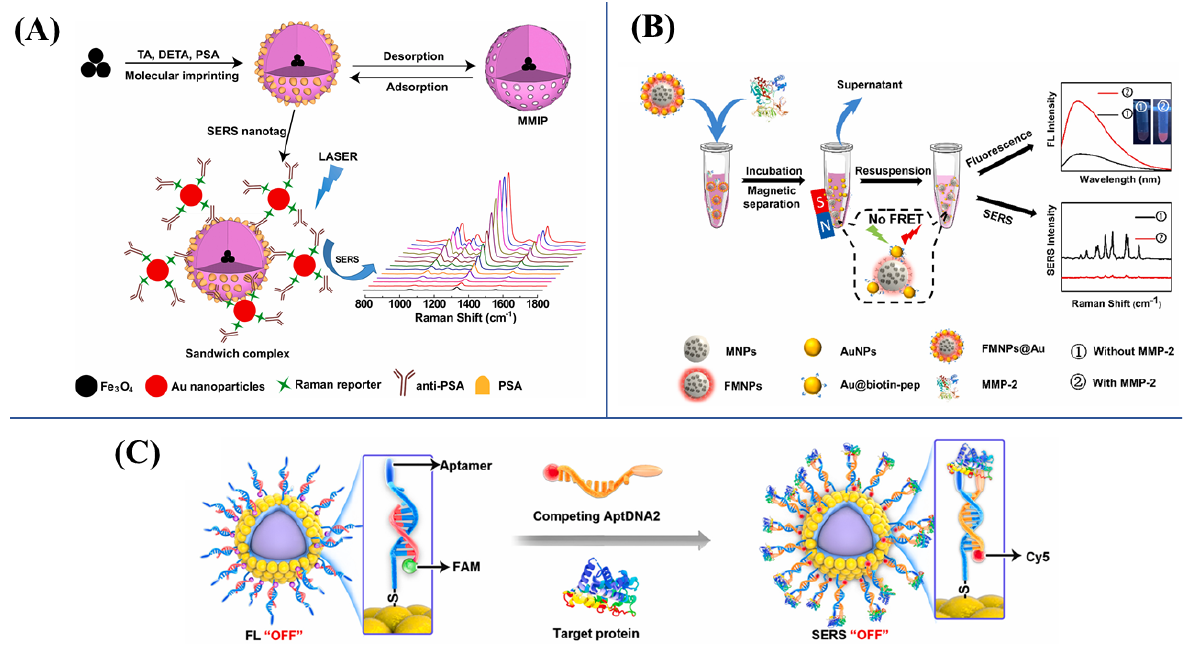
Figure 6. ( A ) Construction of SERS-based platform for PSA detection using MMIPs. Reproduced with permission from Ref. [131]. Copyright 2021, Elsevier. ( B ) Sensing principle of the FMNS@Au dual-mode nanosensor for MMP-2. Reproduced with permission from Ref. [134]. Copyright 2022, Elsevier. ( C ) The DNA strand displacement strategy for SERS-FL dual-mode analysis of vascular endothelial growth factor. Reproduced with permission from Ref. [135]. Copyright 2022, Elsevier.